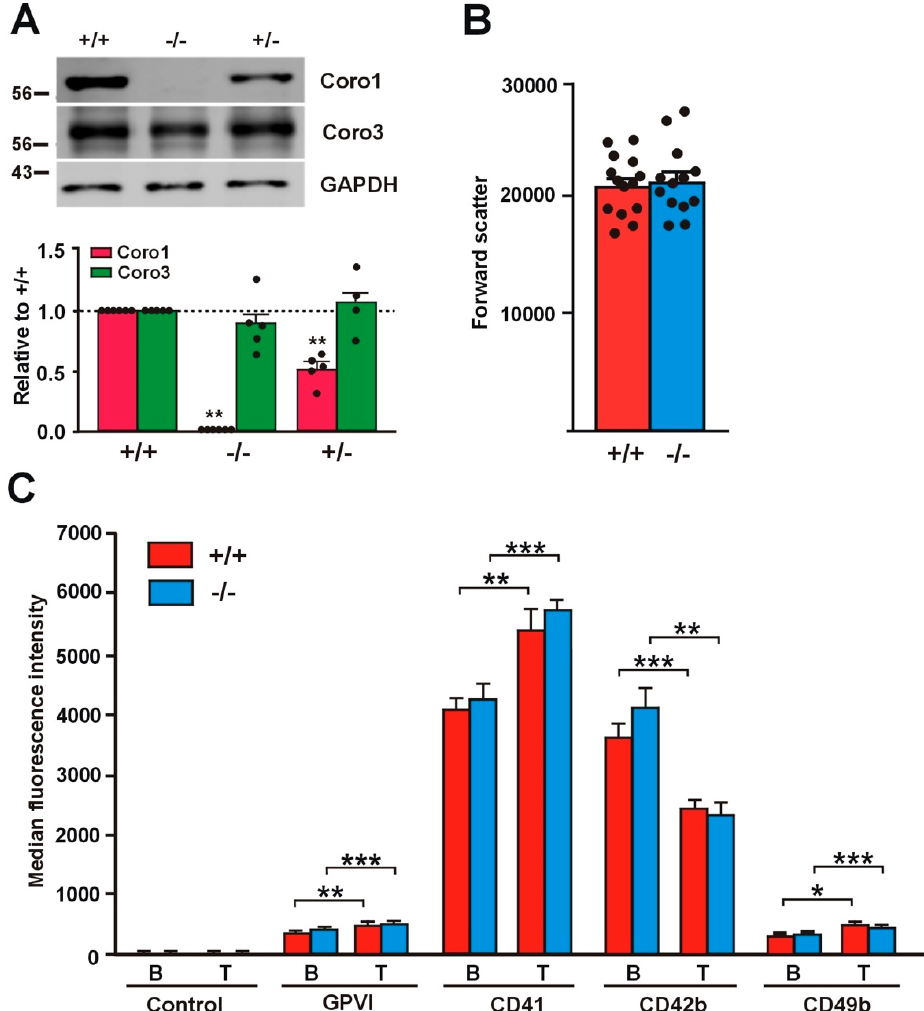
Figure 1. Relative size and receptor expression in Coro1a deficient platelets. ( A ) Absence of Coro1 in Coro1a deficient platelets and no obvious compensation by Coro3. Platelet lysates were resolved by SDS-PAGE, blotted and probed with specific antibodies for the indicated proteins. GAPDH was used for normalization. Data represent mean ± standard error of the mean (SEM) of 4–6 independent experiments. ** p < 0.01; Mann–Whitney U-test. Full blots are shown in Supplemental Figure 1; ( B ) Relative size of Coro1a deficient platelets. Mean platelet volume was estimated in platelet-rich plasma (PRP) by mean forward light scatter area using flow cytometry. Data represent mean ± SEM of 13–14 independent experiments. No statistically significant differences were found, Student’s t -test; ( C ) Surface receptor expression in Coro1a deficient platelets. Platelet surface receptors were determined in PRP by flow cytometry both in basal conditions (B) and upon stimulation with 0.1 U/mL thrombin for 20 min at 37 °C (T). Data represent mean ± SEM of 7–16 independent experiments. * p < 0.05; ** p < 0.01; *** p < 0.001; paired Student’s t -test between basal and stimulated